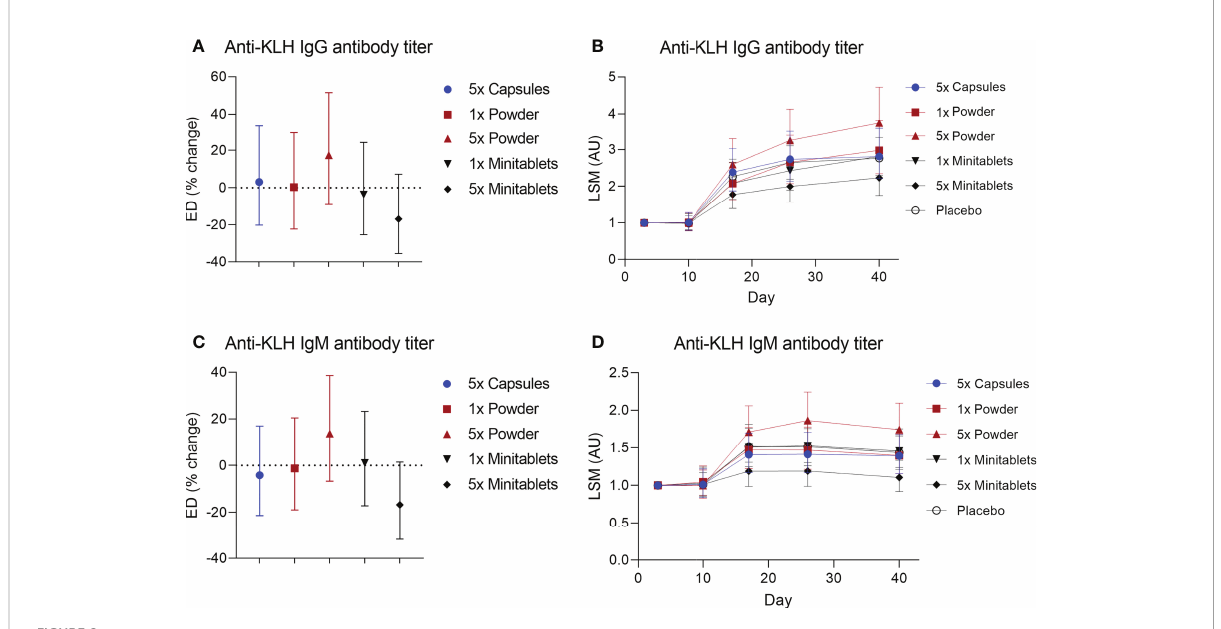
FIGURE 2 Anti-keyhole limpet hemocyanin (A, B) IgG and (C, D) IgM antibody titers by EDP1066 treatment group. Data are shown as estimated difference with 95% con fi dence interval expressed as percentage of placebo in panels (A, C) and as least square means with 95% con fi dence interval in panels (B, D) The estimated difference was calculated with a mixed-effects repeated-measures model with fi xed factors treatment, time and treatment by time, and random factor subject as covariate. KLH, keyhole limpet hemocyanin; ED, estimated difference; LSM, least square